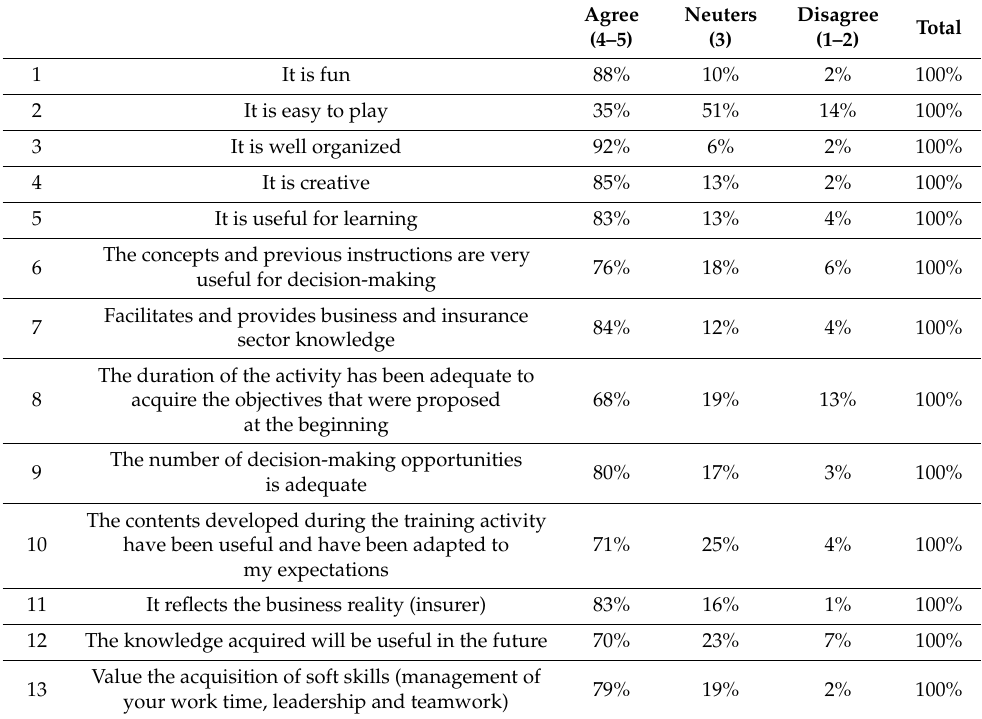
Table 4. Subjective perception of the game